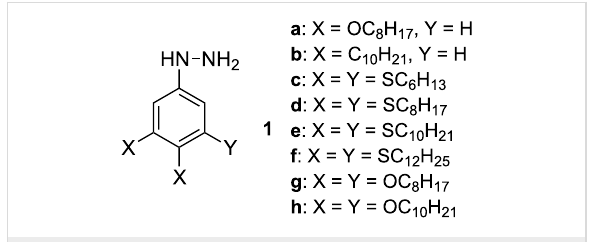
Figure 2: The structures for hydrazines 1a – 1h .